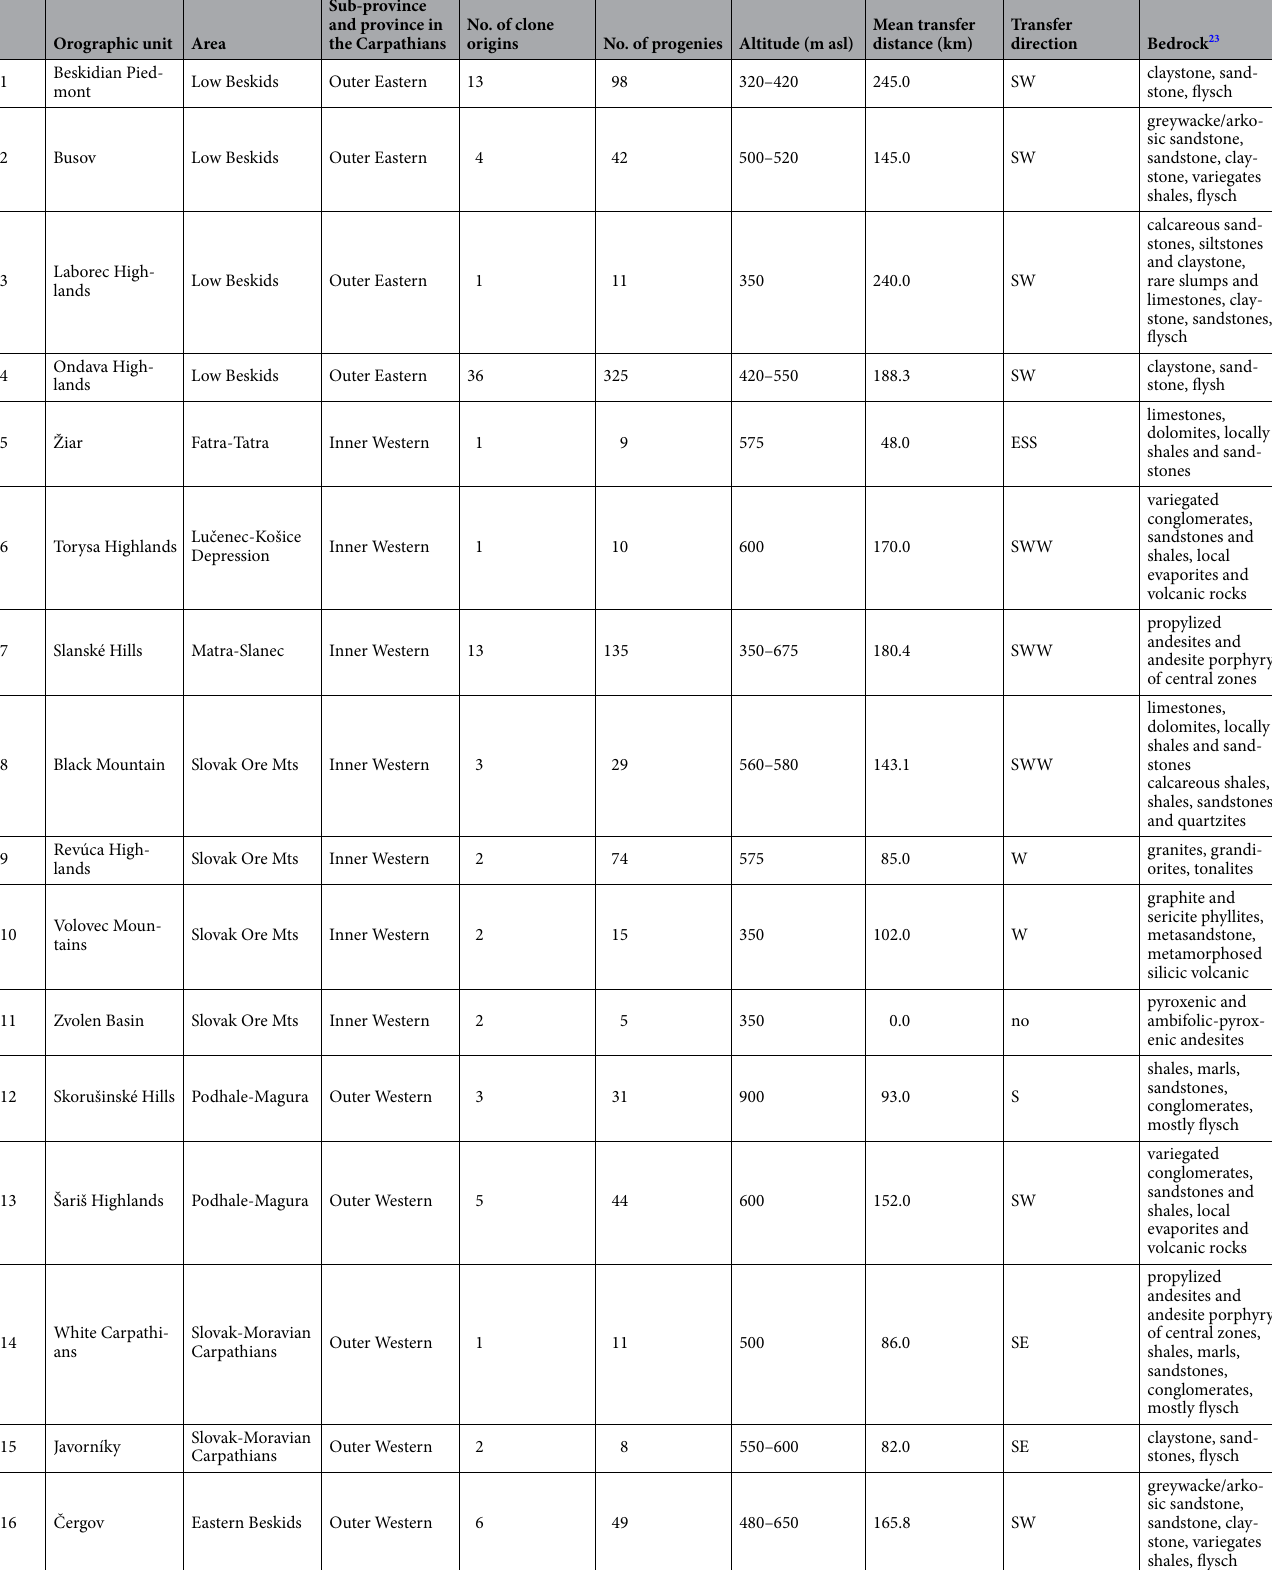
Table 1. Geographic units with natural occurrence of curly birch in Slovakia including the numbers of clones (origins) and the total number of vegetatively propagated individuals used in the study (for details on orographic units see a geomorphological division of Slovakia—https:// en. wikip edia. org/ wiki/ Geomo rphol ogical_ divis ion_ of_ Slova